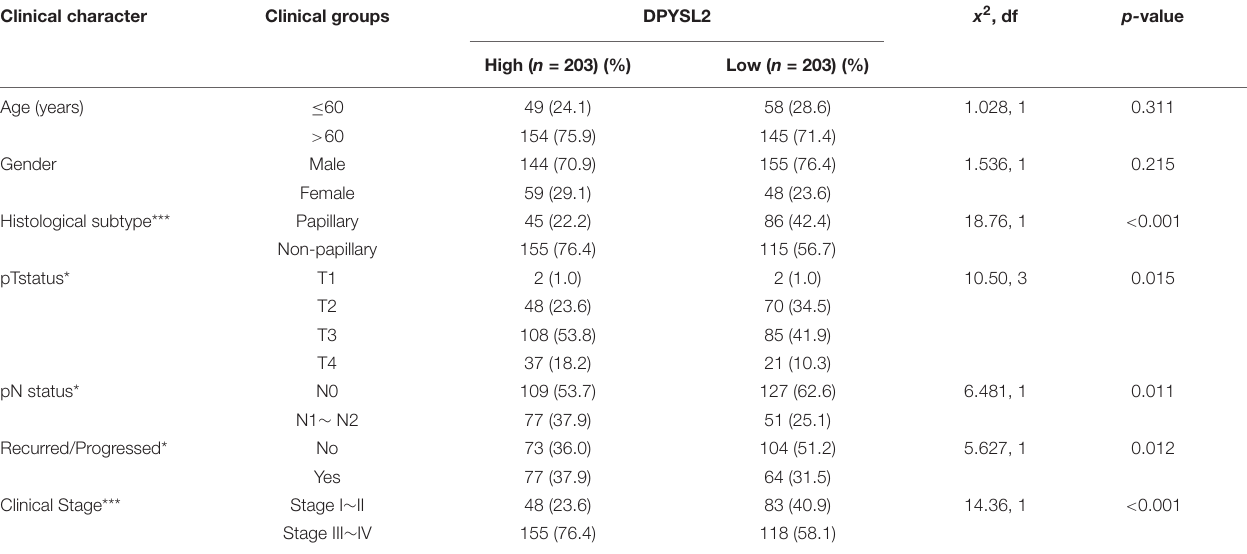
TABLE 1 | Comparison of clinical features between bladder cancer patients with low and high # DPYSL2 mRNA levels in the TCGA database. Clinical